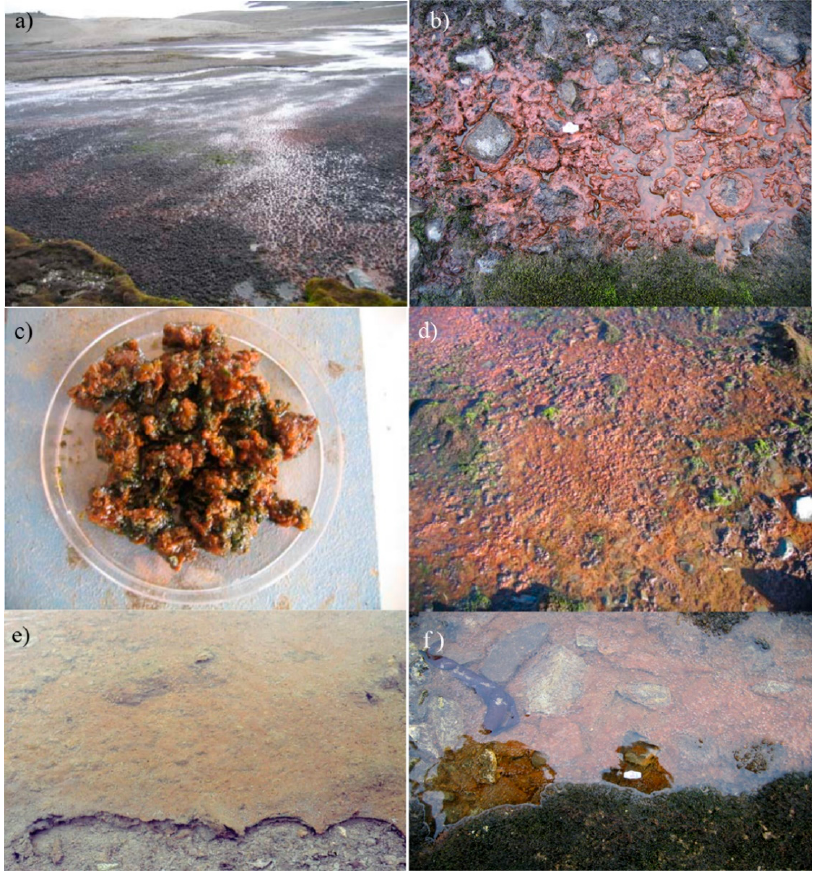
Figure 7. Photographs of different microbial mats studied in Byers Peninsula. ( a,b ) soil mat; ( c,d ) pond mat; ( e,f ) stream mat (names according to Fernandez-Valiente et al. [19]).